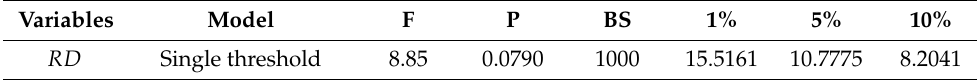
Table 6. Threshold affect test results.